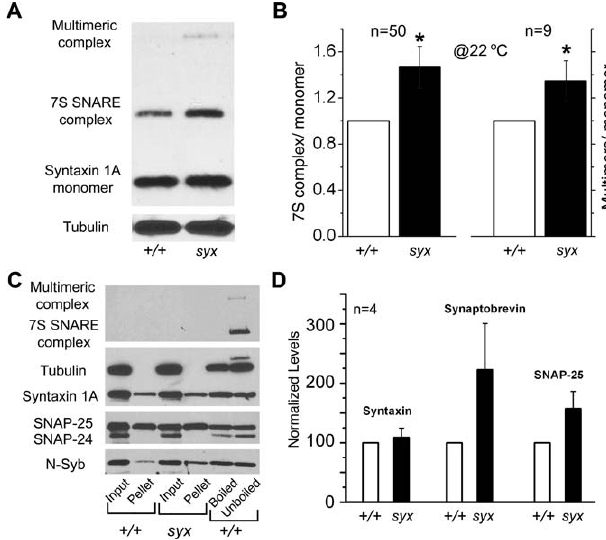
Figure 6. The Assembly of SDS-Resistant SNARE Complexes Is Increased in syx 3–69 Mutant Flies at Permissive Temperatures (A and B) The amount of SDS-resistant 7S complex as well as the multimeric complex is significantly increased in homozygous syx 3–69 mutant flies at 22 8 C. A representative Western blot shows the syntaxin 1A monomer, the 7S SNARE complex, and the multimeric complex obtained from heads of the wild type ( þ / þ ) and the mutant ( syx [A]). The relative level of total proteins loaded in the lanes is illustrated by the intensity of tubulin. Histograms of ratios of the 7S and multimeric complexes to monomer in wild-type and syx 3–69 mutant flies are shown in (B). *, p , 0.05. (C and D) Western blots show the SNARE complexes, tubulin, syntaxin 1A, SNAP-25, and N-Syb from fly-head extract inputs, immunoprecipi- tates (pellets), and SDS head extracts. The head extracts used for immunoprecipitation were obtained from the wild-type ( þ / þ ) and the syx 3–69 mutant (syx) flies and incubated with Sepharose bead–coupled SNAP-25 antibodies. Inputs and precipitates were boiled in SDS sample buffer before loading. One of the SDS head-extract samples was not boiled to preserve the SDS-resistant SNARE complexes. The Western blot was sequentially probed with a syntaxin 1A antibody for SNARE complexes and syntaxin 1A monomers, a different SNAP-25 antibody for SNAP-25 (which also recognizes SNAP-24), an N-Syb antibody for N- Syb, and a tubulin antibody for tubulin. Note that tubulin is absent from pellet and that the SNARE complexes are only present in the unboiled SDS head extracts. SNAP-24 is present only in the input lanes and the SDS extracts; it is absent from the pellets because the IP antibody is specific for SNAP-25. Compared to the wild-type lanes, there are slightly more N-Syb, syntaxin 1A, and SNAP-25 in the precipitates from the syx 3–69 mutant (syx) mutant flies.